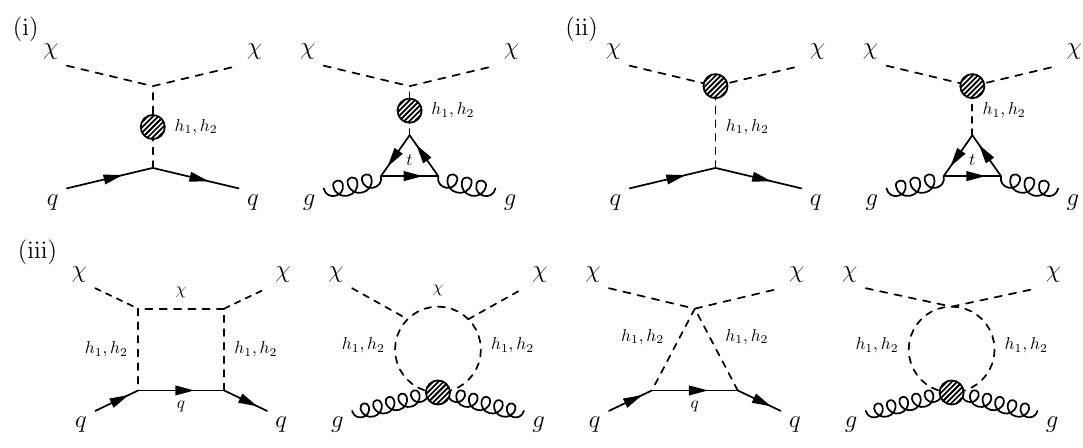
Figure 1 . Feynman diagrams for (cid:31) - q and (cid:31) - g scattering